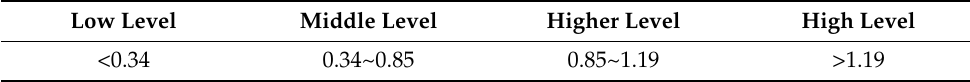
Table 3. Classification standard of